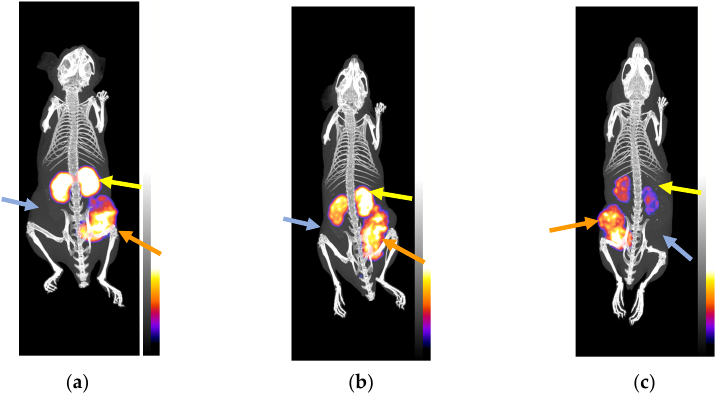
Figure 5. Static whole ‐ body SPECT/CT images of SCID mice bearing twin HEK293 ‐ SST 2 R and wtHEK293 tumors in their flanks at ( a ) and ( b ) 4 h pi and ( c ) at 24 h pi of [ 111 In]In ‐ AAZTA 5 ‐ LM4; orange arrows are pointing to HEK293 ‐ SST 2 R xenografts and light blue arrows to wtHEK293 tu ‐ mors, devoid of SST 2 R expression. Intense uptake is observed in the SST 2 R ‐ expressing tumors but no uptake is evident in the negative controls. Yellow arrows are directed toward the kidneys; the initial kidney uptake at ( a ) and ( b ) 4 h pi notably declines at ( c ) 24 h pi. The color bars indicate the difference in accumulated activity (purple being the lowest and white the highest level of accumu ‐ lation).